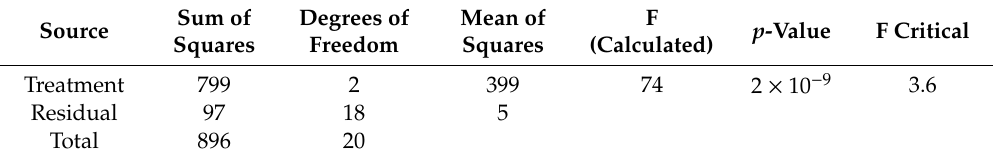
Table 1. Analysis of variance (ANOVA) applied to the back-face signature (BFS) results of all armor plates tested. Source